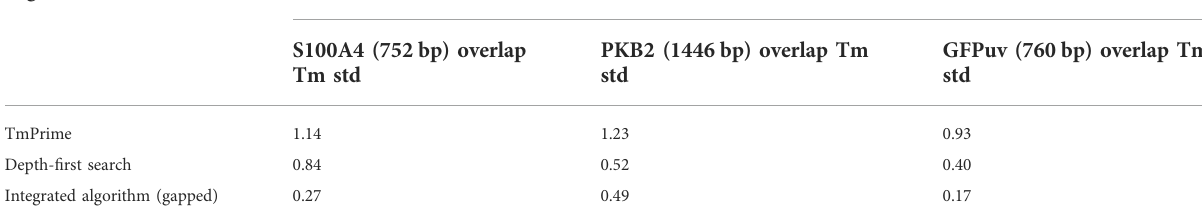
TABLE 3 Oligonucleotide set designed by three algorithms. Compared to other algorithms, the depth- fi rst search algorithm does not surpass the integrated algorithm, but it takes less time to process. For a fair comparison, the algorithms were tested under the same conditions.